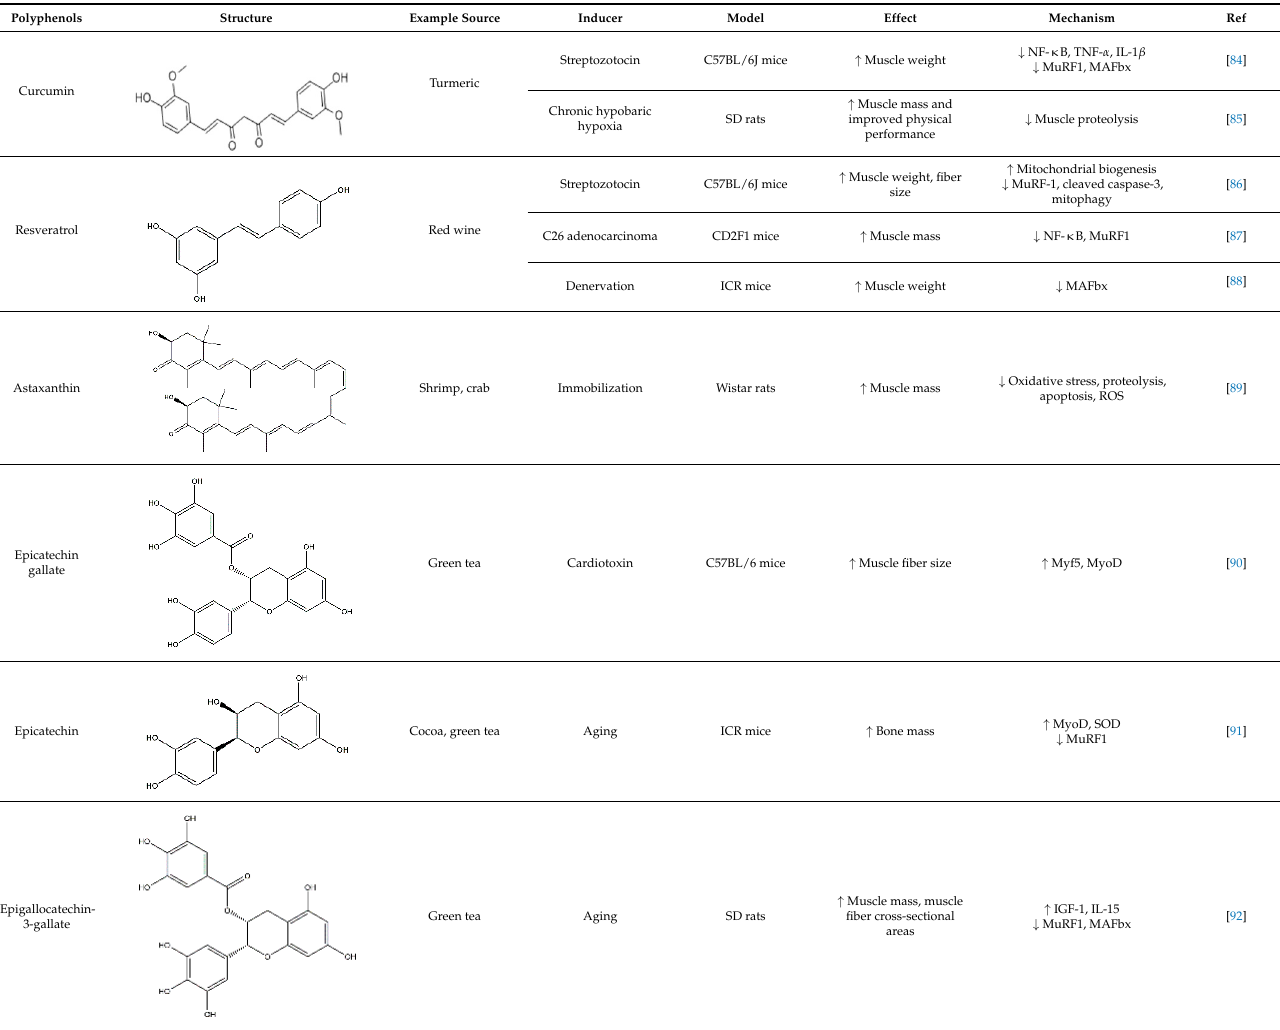
Table 5. Polyphenols in the prevention of the muscle atrophy in vitro/vivo.